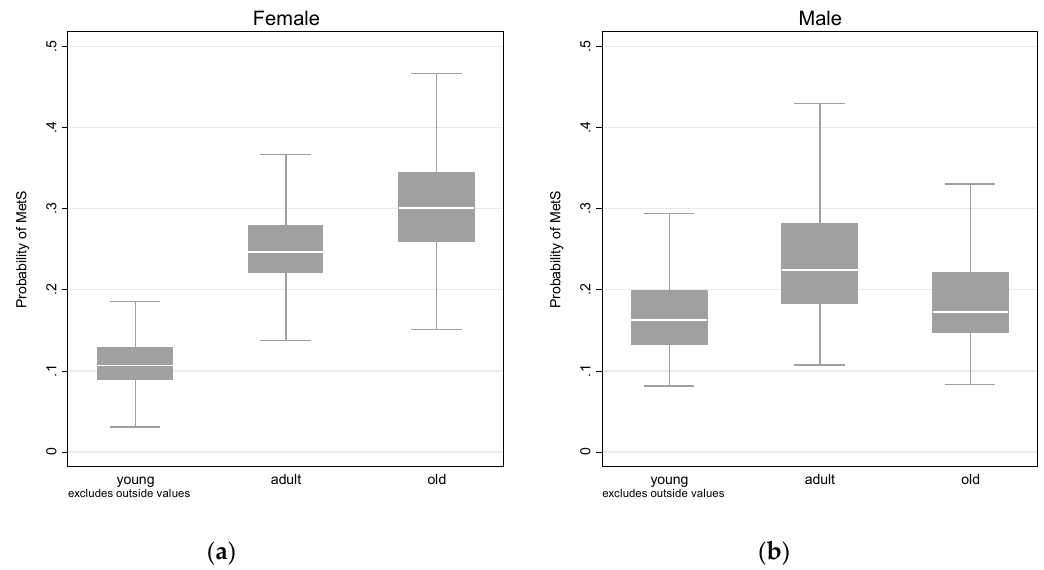
Figure 2. Predicted probability of having a metabolic syndrome diagnosis, at each age cohort. ( a ) Association for female ( b ) Association for male. Note: The box indicates the 75% and 25% percentiles, and the white line within the box indicates the median value. Two grey horizontal lines refer to the upper and lower adjacent values. Young is defined as ≤ 45 years; adult is defined as > 45 y and ≤ 60 years; old is defined as > 60 years.